Question: Briefly state, in one sentence, what is plotted here.
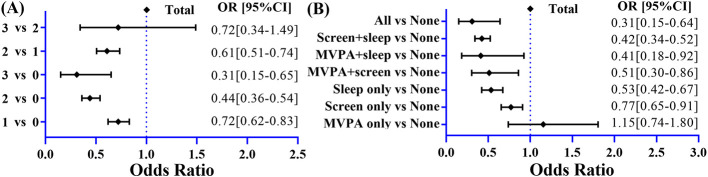
Answer: Associations between adherence to 24-h movement guidelines and NSSI. (A) ORs (95% CIs) for NSSI by number of met guidelines. (B) ORs (95% CIs) for NSSI by guideline combinations. OR, odds ratio; CI, confidence interval.